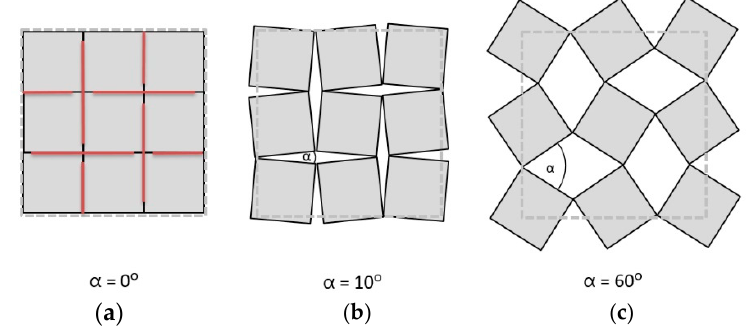
Figure 2. The geometry of auxetic rotating squares structures: ( a ) undeformed structure and ( b , c ) deformed structures.